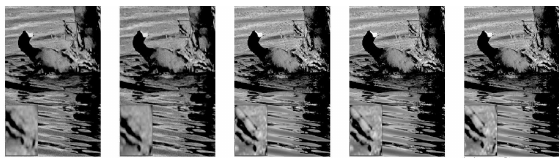
Fig. 6. Figure 6. Comparison of denoising effects of different loss functions (duck). (a) L1+Percep (b) Wass+Percep (c) Percep (d) MSE+Percep (e) MSE+Wass+Percep.